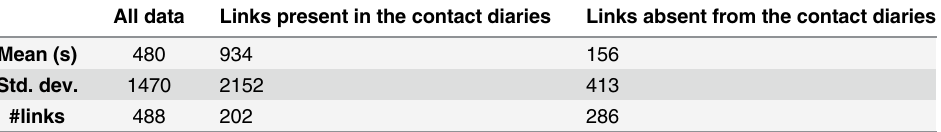
Table 3. Average and standard deviation of the distributions of aggregate durations for different sets of links (as in Fig 4). All data Links present in the contact diaries Links absent from the contact diaries